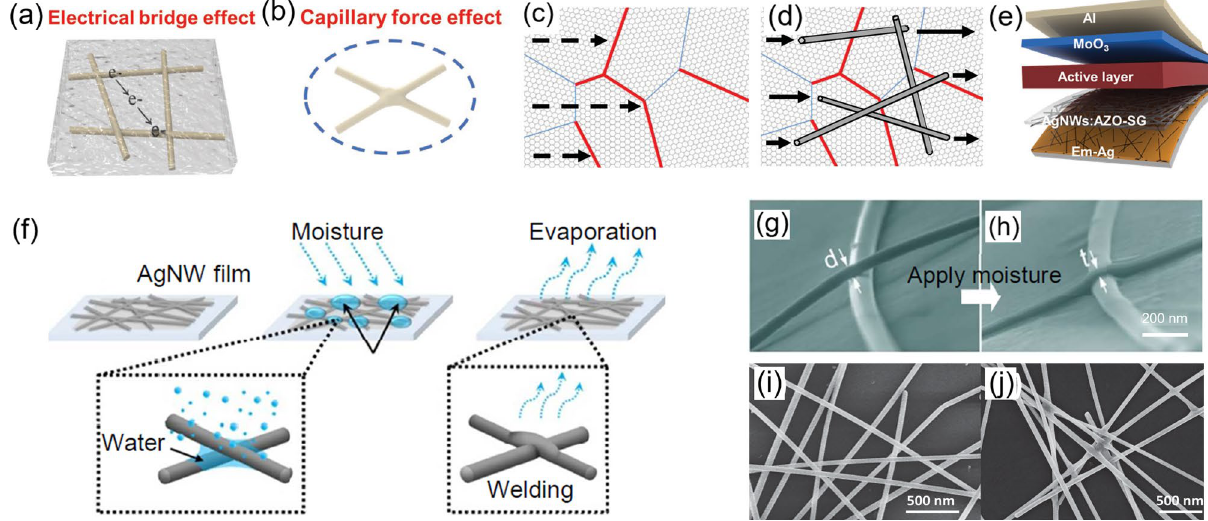
Fig. 5 Illustration of a the electrical bridge effect and b the capillary force effect. The illustration of the co-percolating conduction for AgNWs/ graphene composite electrode ( d) compared to the single layer graphene with has high-resistance grain boundaries (red lines) ( c) . e Schematic illustration of FPSCs based on the embedded-Ag/AgNWs: AZO-graphene hybrid electrode. f Schematic of welding the AgNWs via water treat- ment induced capillary force. The SEM images of AgNWs junctions g before and h after water treatment, i before and j after chemical treatment. a , b , e Reproduced with permission from Ref. [109]. Copyright 2020, John Wiley and Sons. c , d Reproduced with permission from Ref. [120]. Copyright 2013, John Wiley and Sons. f, g, h Reproduced with permission from Ref. [122]. Copyright 2017, American Chemical Society. i, j Reproduced with permission from Ref. [124]. Copyright 2015, John Wiley and